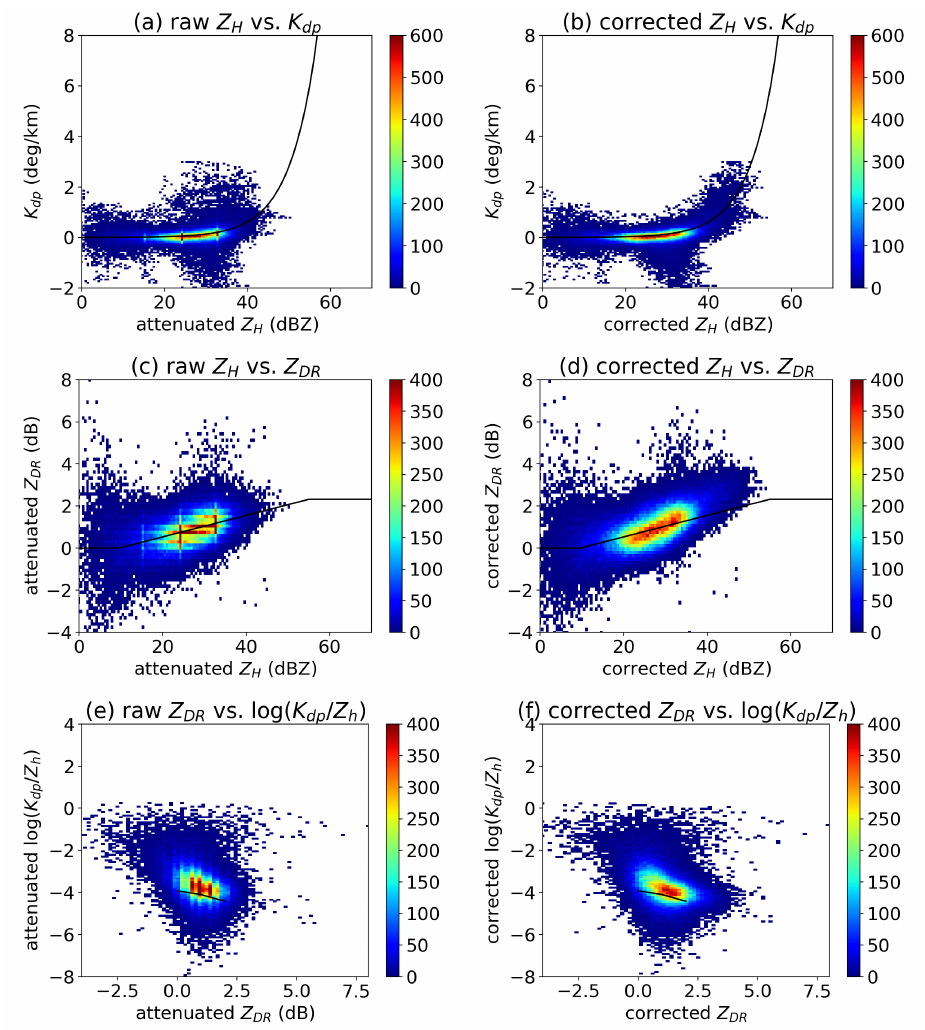
Figure 7. Same as Figure 4, but the data were collected at 0339 UTC on 3 July